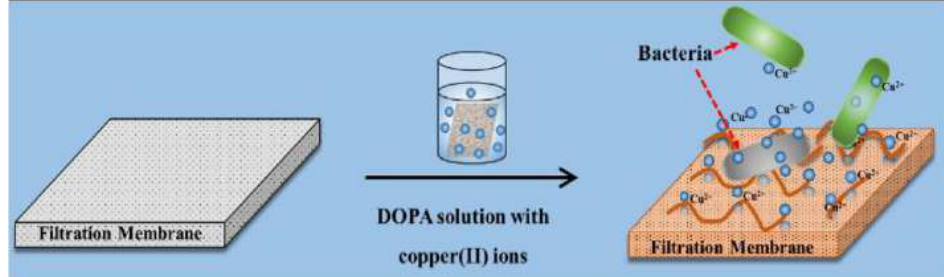
Figure 8. Schematic of the one-pot chelating copper ions modification on FO membrane. Copper ion release and interac- tions between bacteria and the copper-containing surface results add biocide properties. Extracted from